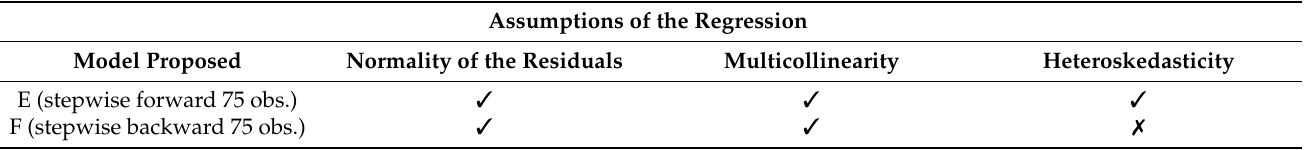
Table 7. Comparison of statistical assumptions for models E and F generated from a step-by-step